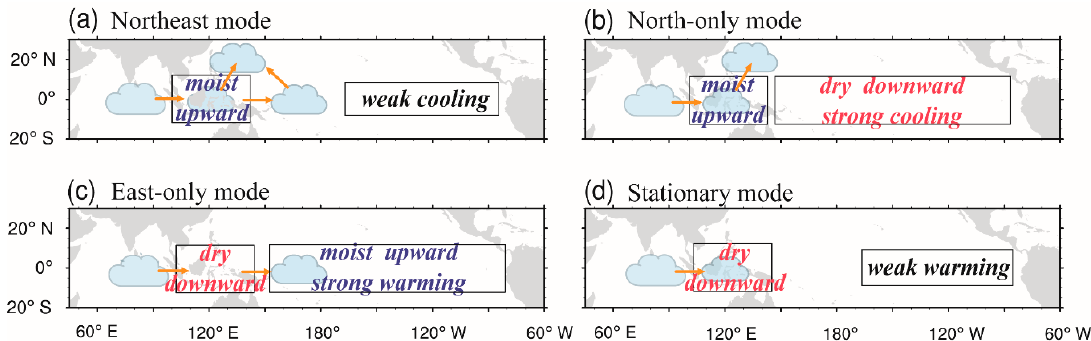
Figure 6. Schematic diagram for the four modes studied. Shown are the different BSISO propagation and associated mean state change for ( a ) northeast mode, ( b ) north-only mode, ( c ) east-only mode, and ( d ) stationary mode. Clouds denote the BSISO convective center. Arrows denote the propagation of convection, and rectangles denote key regions with different mean state change.